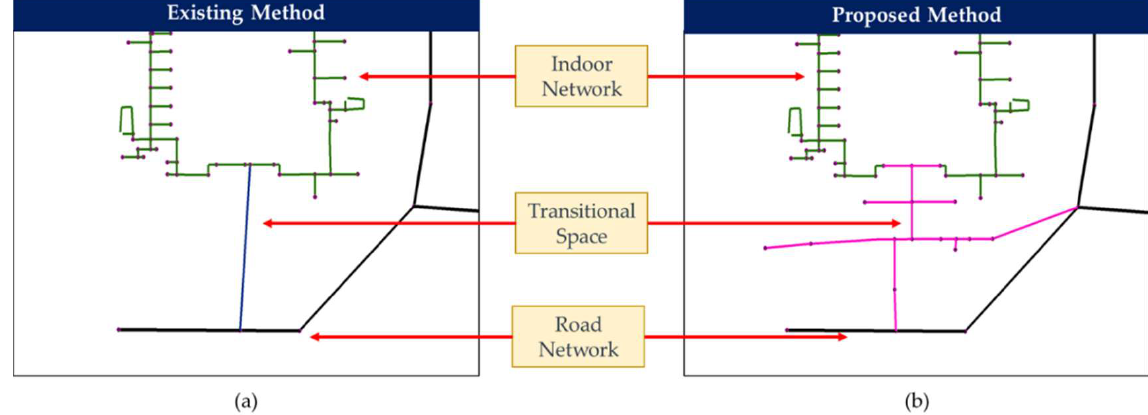
ISPRS Int. J. Geo-Inf. 2021 , 10 , 565